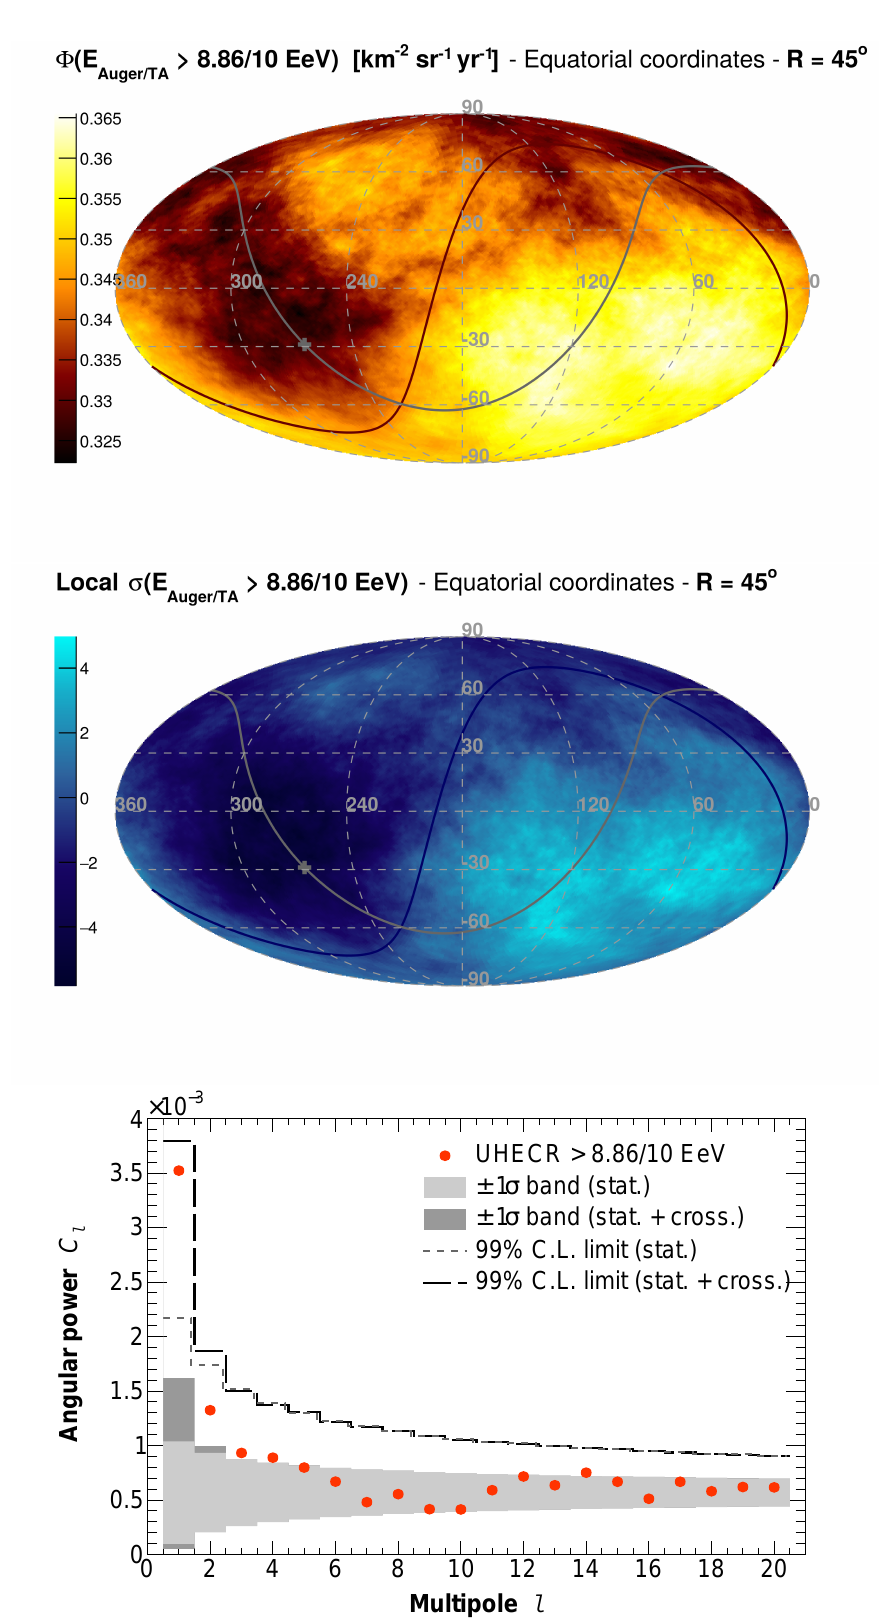
Figure 3. Flux ( Top ) and significance ( Mid-panel ) maps reconstructed at E Auger / TA > 8 . 86 / 10EeV. The gray line indicates the Galactic plane and the dark line the supergalactic plane. Bottom: Angular power spectrum at E Auger / TA > 8 . 86 / 10EeV. The light-gray band indicates the ± 1 σ confidence region for an isotropically distributed signal derived from the limited statistics over the full sphere. The dark-gray band further accounts for the uncertainty arising from the limited statistics in the cross-calibration band. Light-gray short- dashed and dark-gray long-dashed lines similarly indicate the 99% confidence level upper limits derived under the assumption of an isotropic